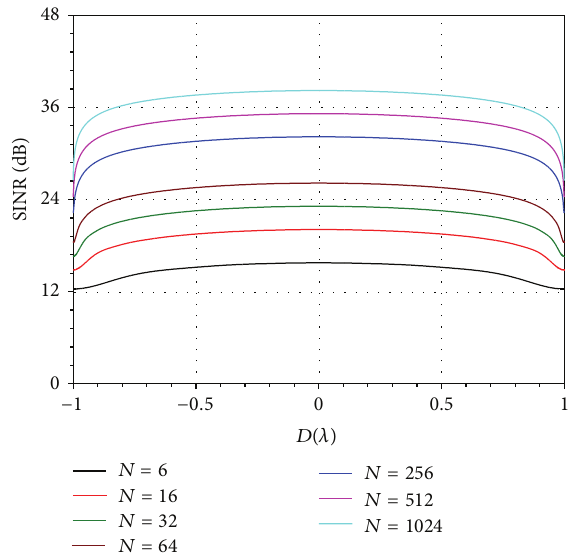
Figure 6: Comparison of output SINR in the presence of mutual coupling by varying the number of antenna elements.